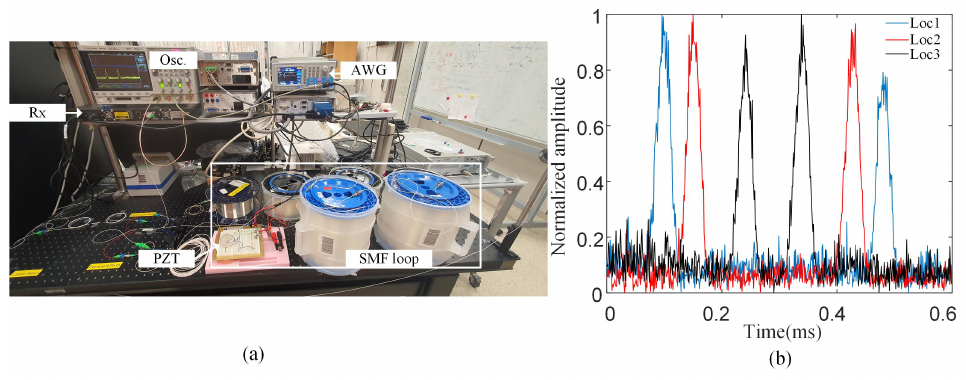
Figure 8. ( a ) Experimental setup, and ( b ) received sensed signals of the three defined events.